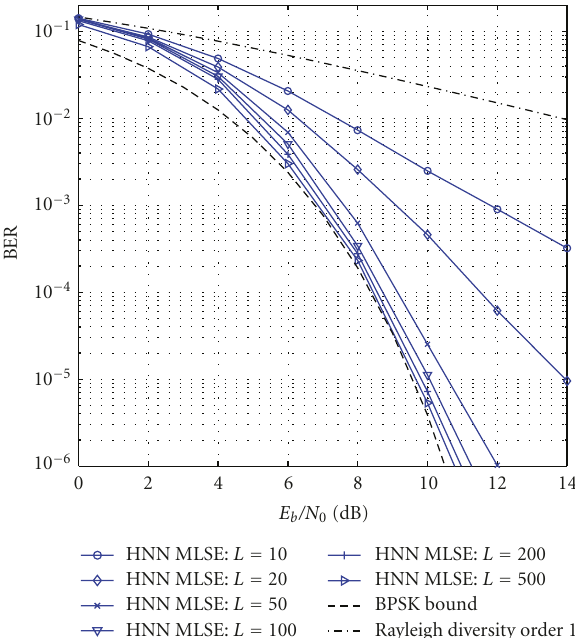
Figure 14: BPSK HNN MLSE equalizer performance in extremely long